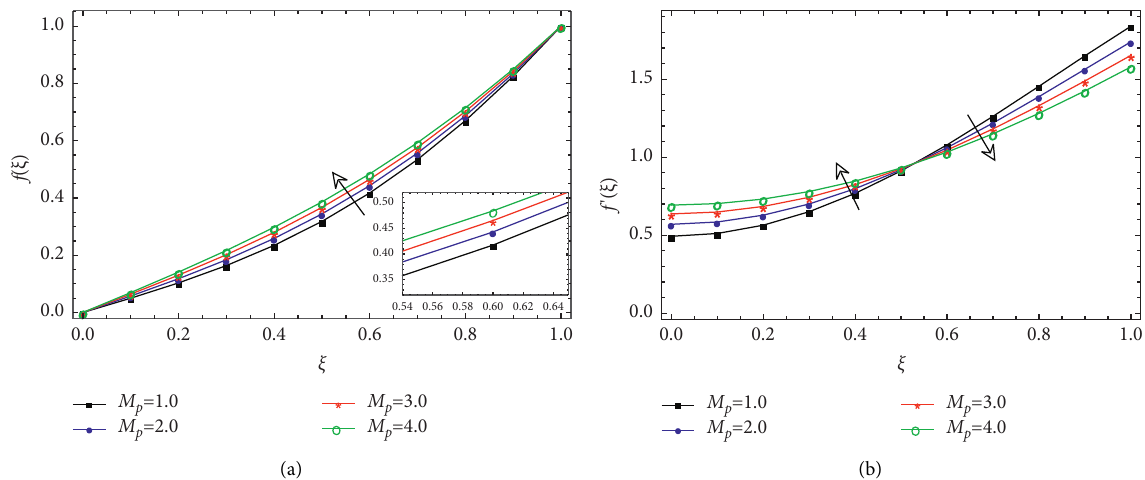
R � 1 . 5, M � 1, and c � 1 fixed in case of slip. (a) Normal component of velocity. g